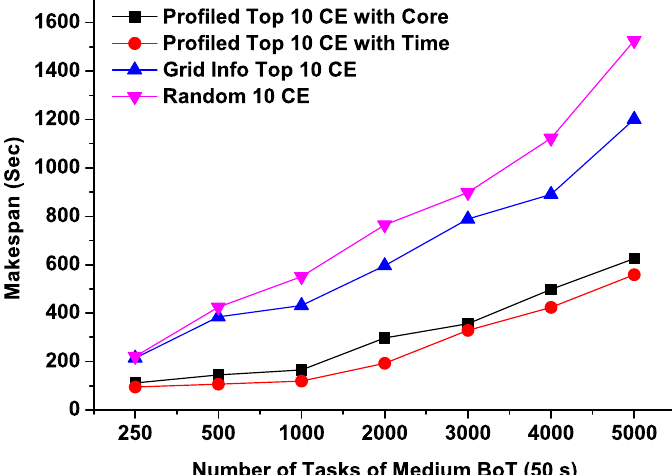
Figure 8. Makspans of Medium BoT jobs with four sets of computing resources.